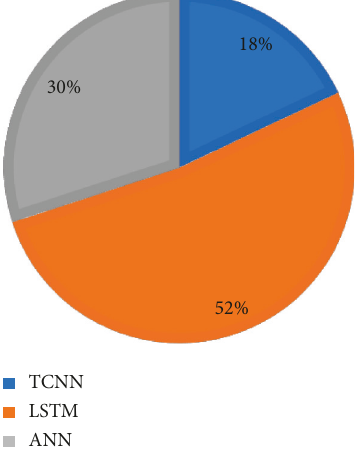
Figure 4: Published papers by